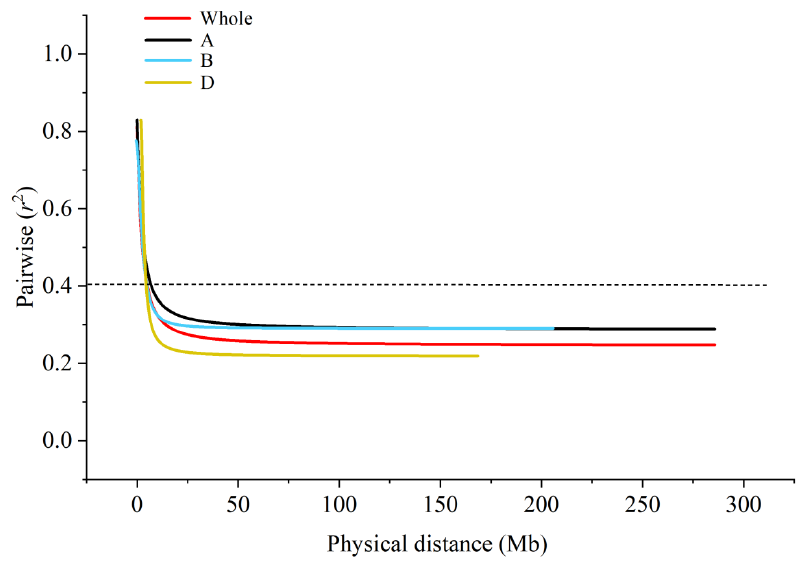
Figure 2. Linkage disequilibrium (LD) decay across the whole wheat genome, A, B, and D sub- genomes within the association panel consisted of 150 wheat varieties (lines) over a 300 Mb physical distance. The horizontal line indicates the critical value of r 2 .